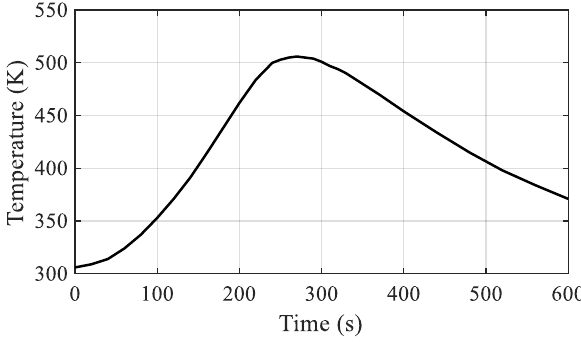
Figure 4. Interfacial temperature during the joining process (hollow cylinder specimens).